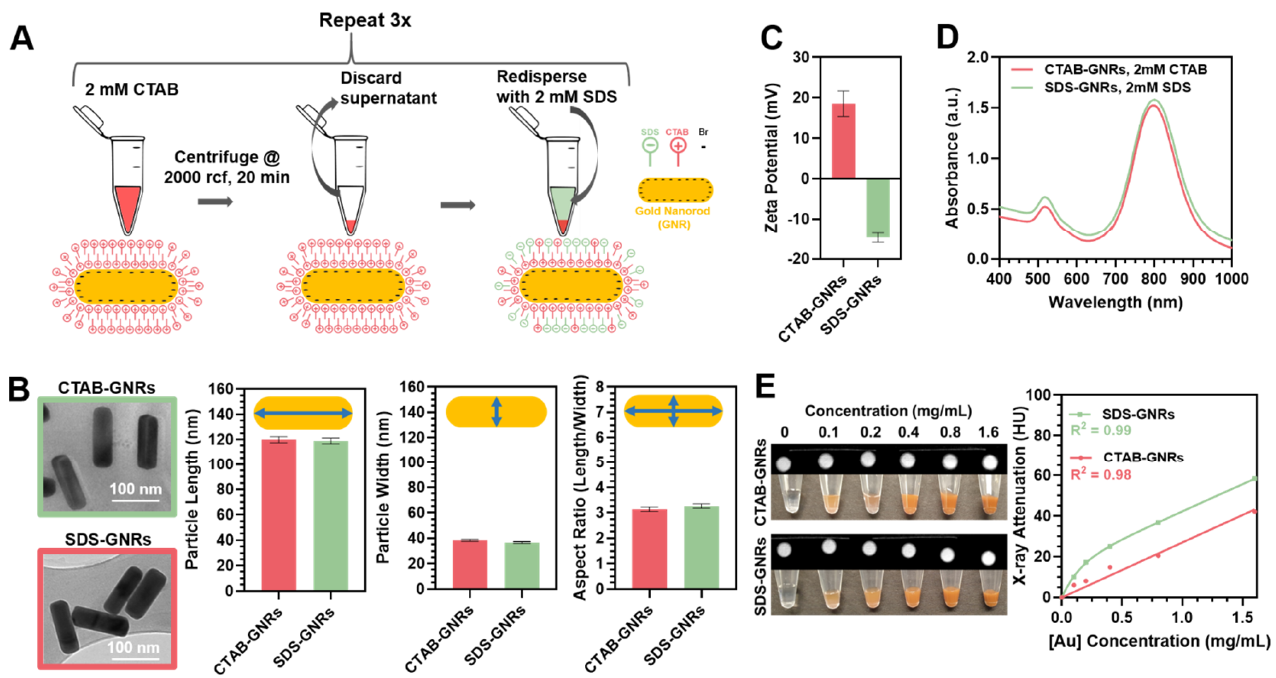
Figure 1. Surface chemistry modification and characterization of CTAB-GNRs and SDS-GNRs. ( A ) Schematic of the surface chemistry modification process of the nanorods with CTAB and SDS surfactants. ( B ) Transmission electron microscopy (TEM) images of the particles and quantification of particle length, width and aspect ratio. ( C ) Zeta potential and ( D ) absorbance spectra of the nanorods stabilized with CTAB and SDS. ( E ) X -ray attenuation of the nanorods as a function of gold concentration obtained using a micro-CT source. CT contrast (upper view) and photos (lower view) for each sample dilution. X -ray attenuation as a function of gold concentration is plotted. Data points are fit using linear regression (CTAB-GNRs) where y= 24.7x + 2.5 or two-phase association (SDS-GNRs) where y= 151.1 × (1 − e −6.9x ) + 45658.2 × (1 − e −6.9x ).